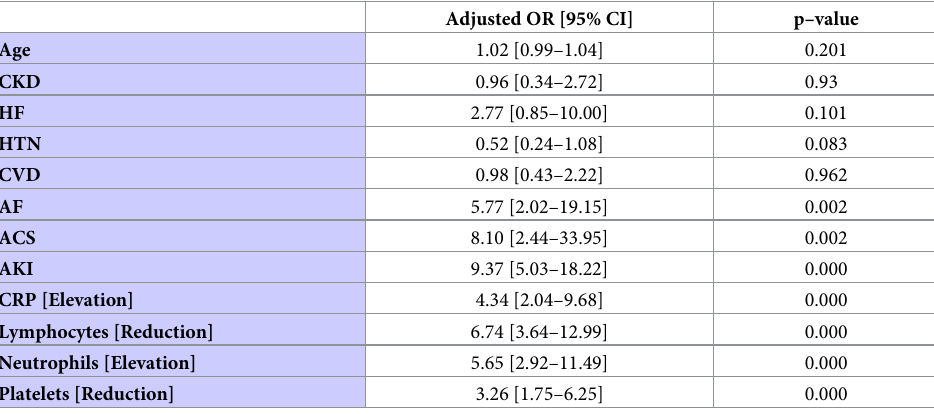
Table 7. Multivariate logistic regression analysis for the factors affecting the